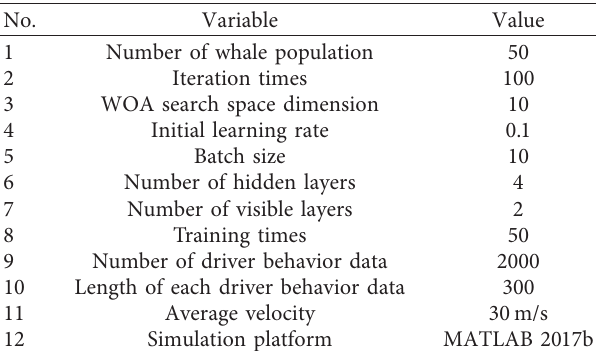
Table 2: The initial